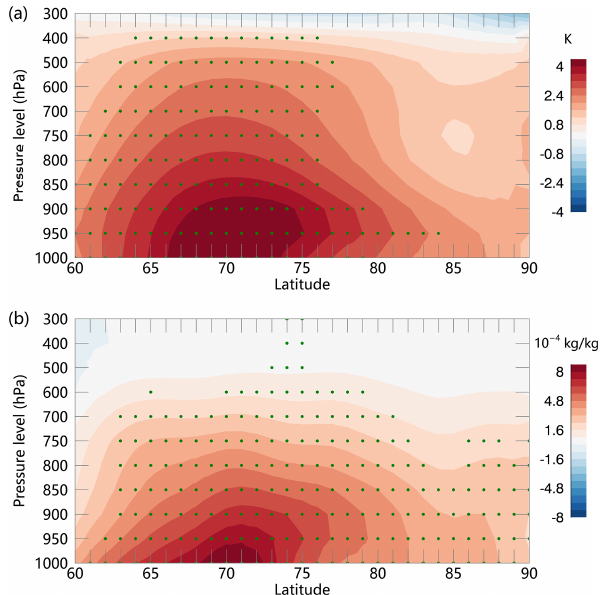
Figure 4. Vertical cross sections of zonal averaged (a) air temper- ature and (b) specific humidity anomalies, as a function of lati- tude and pressure level, during the spring months (April to June) of 2020 spanning the regions with significant energy and moisture convergence (60–165 ◦ E, 60–90 ◦ N). The anomalies are calculated as the difference between the averaged fields of the 3 months (April to June) and the corresponding 1979–2020 climatology. Stipplings represent the values where the anomaly exceeds 2 standard devia-